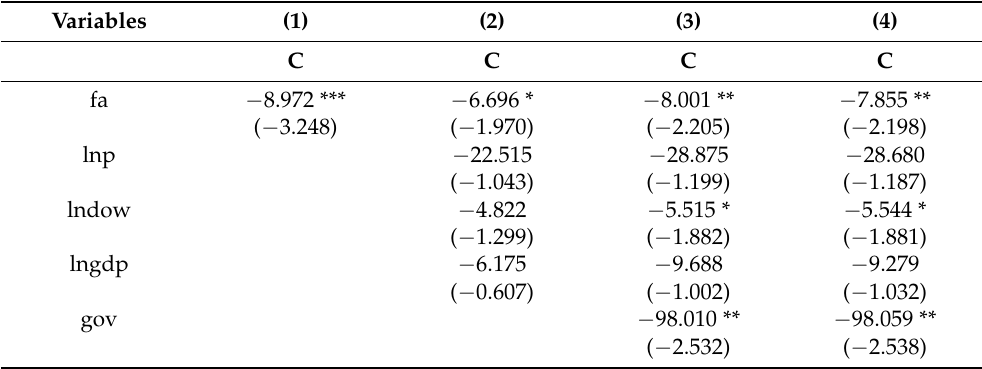
Table 2. Benchmark